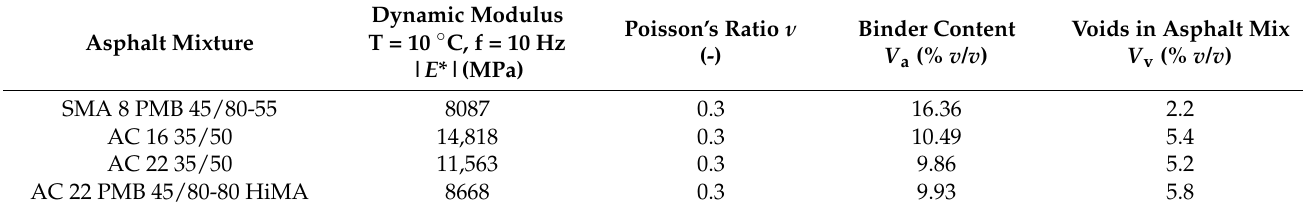
Table 3. Material parameters of asphalt mixtures (cont.).